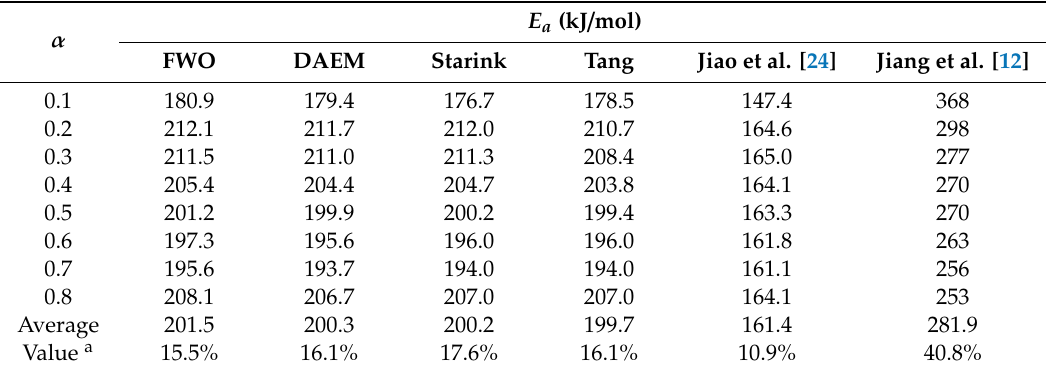
Table 2. The E a is calculated by four methods based upon thermogravimetric data.